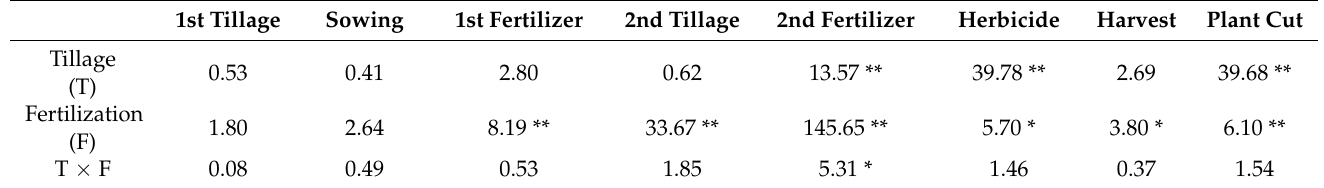
Table 3. Summary of multivariate analysis of variance for the effect of tillage and fertilization on the emission of CO 2 in different corn crop